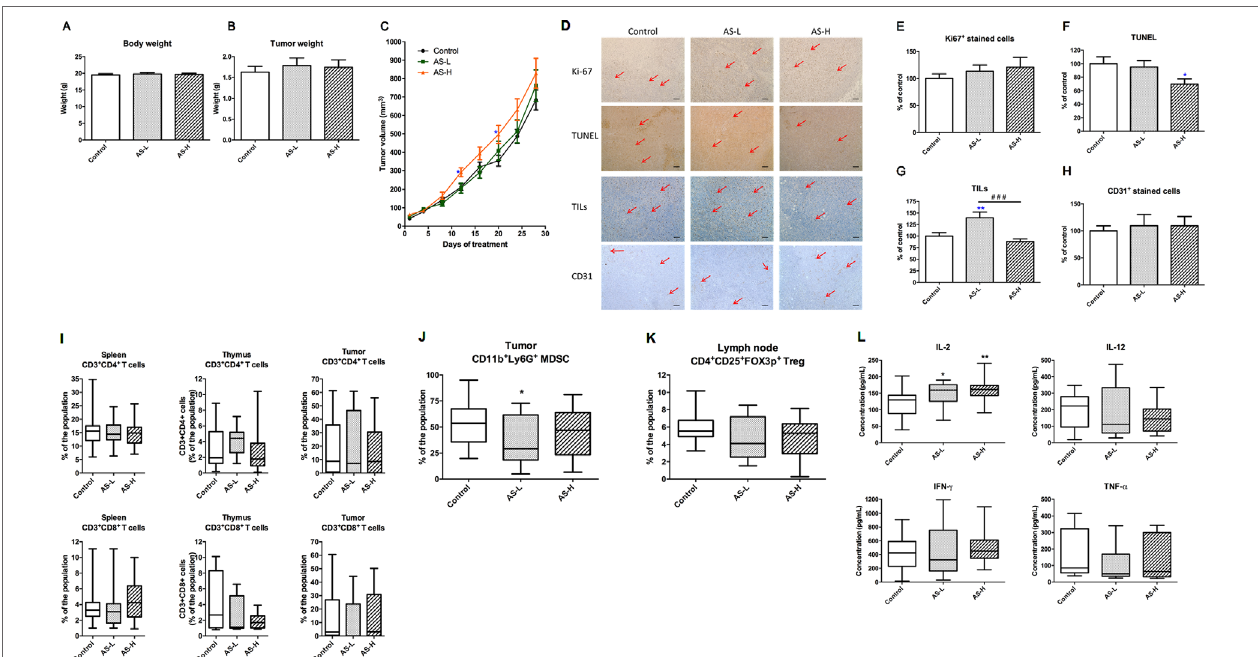
FIGURE 4 | Tumor growth of 4T1 tumor-bearing mice. Mice were treated with AS-L (0.75 g/kg) or AS-H (1.5 g/kg) daily for 4 weeks. (A) Body and (B) tumor weights of mice after AS treatments were recorded at the end of treatment. Data were expressed as mean + SEM, n = 16–20. (C) Tumor volume of mice in each group was measured twice a week during treatments. (D–H) Effects of AS treatments on the expressions of Ki67 and CD31 in the tumor sections. The number of tumor infiltrating lymphocytes (TILs) and the apoptotic area (assessed using TUNEL assay) were also assessed in the tumor sections excised from 4T1